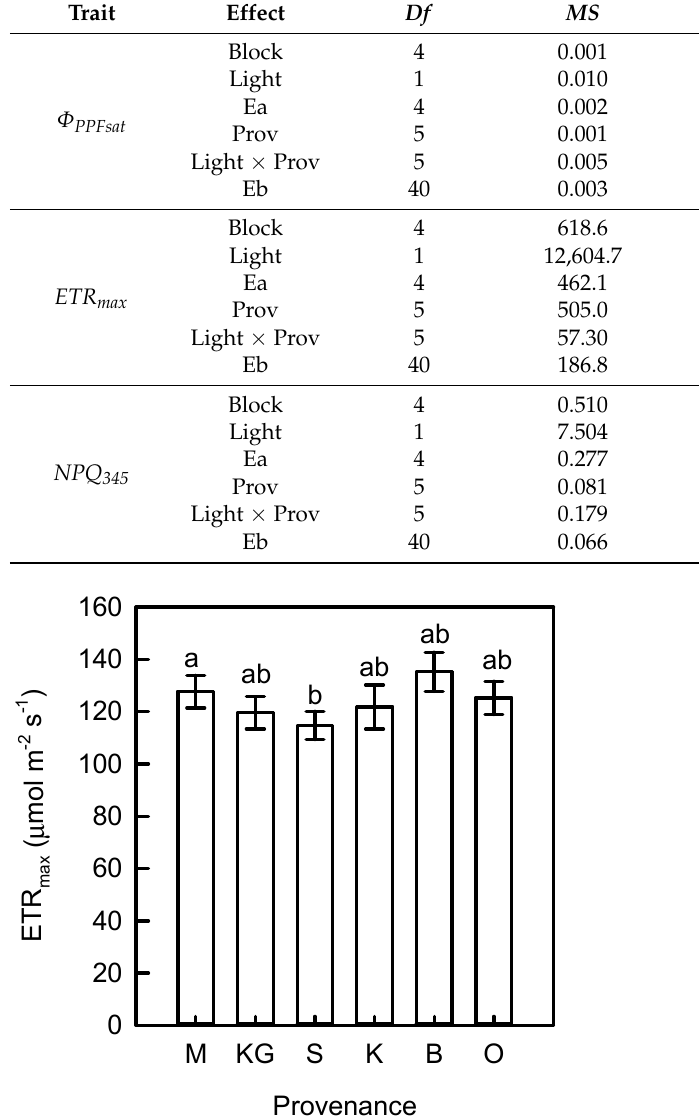
Figure 3. Maximal electron transfer rate (mean ± SE) of Abies alba seedlings originating from different provenances. The results of ANOVA are shown in Table 5. The same letters above columns indicate that the mean values of ETR max do not differ significantly among the provenances in a posteriori Tukey’s test at p < 0.05 ( n = 10). The provenances are ranged from south to north: M—